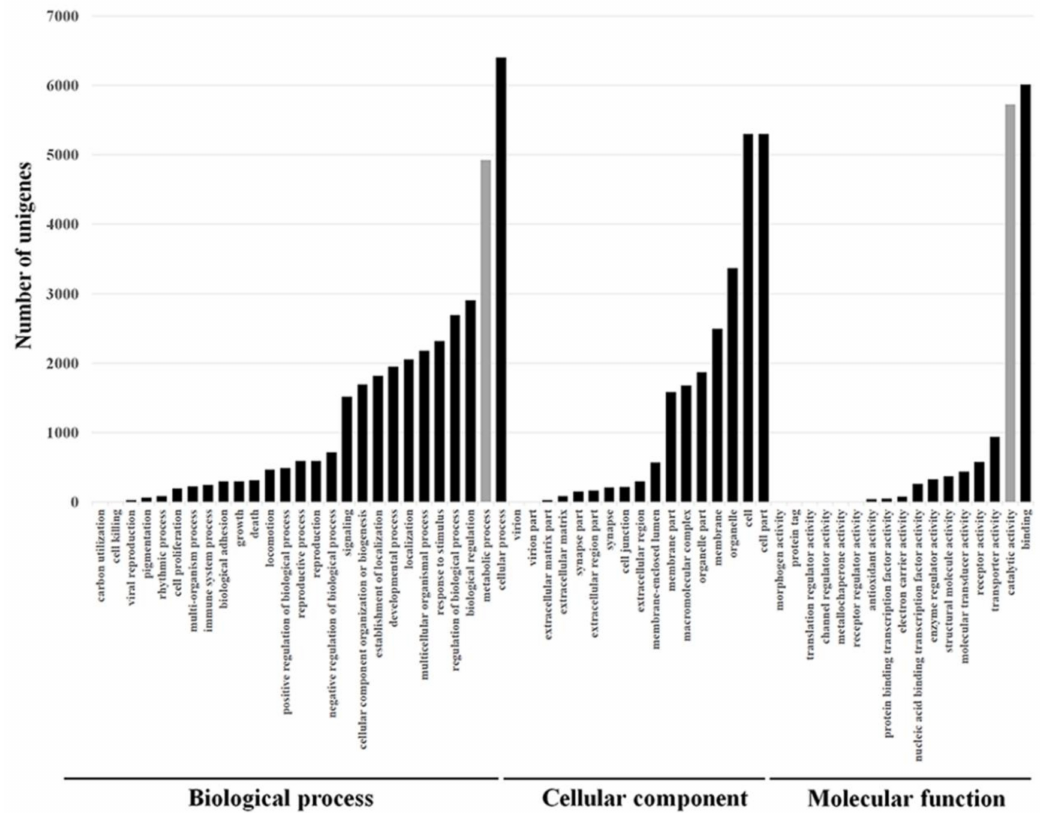
Figure 3. Gene Ontology (GO) classification of assembled unigenes from thrips tabaci transcriptome into biological process, cellular component, and molecular unction presented as absolute number of unigenes in each subcategory. The categories were obtained using Blast2GO